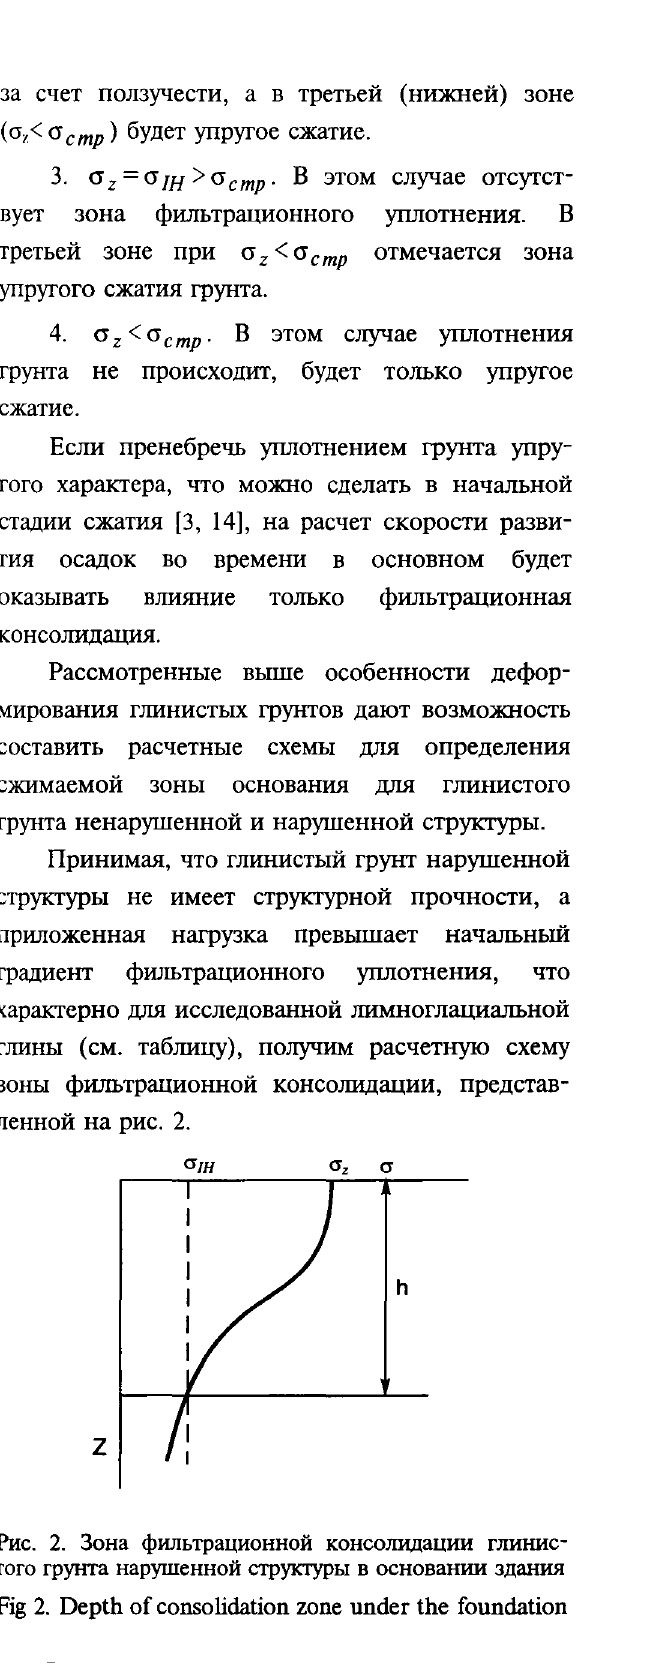
Fig 2. Depth of consolidation zone under the foundation B rJIHHHCTOM rpYJITe HeHapyrneHHOH